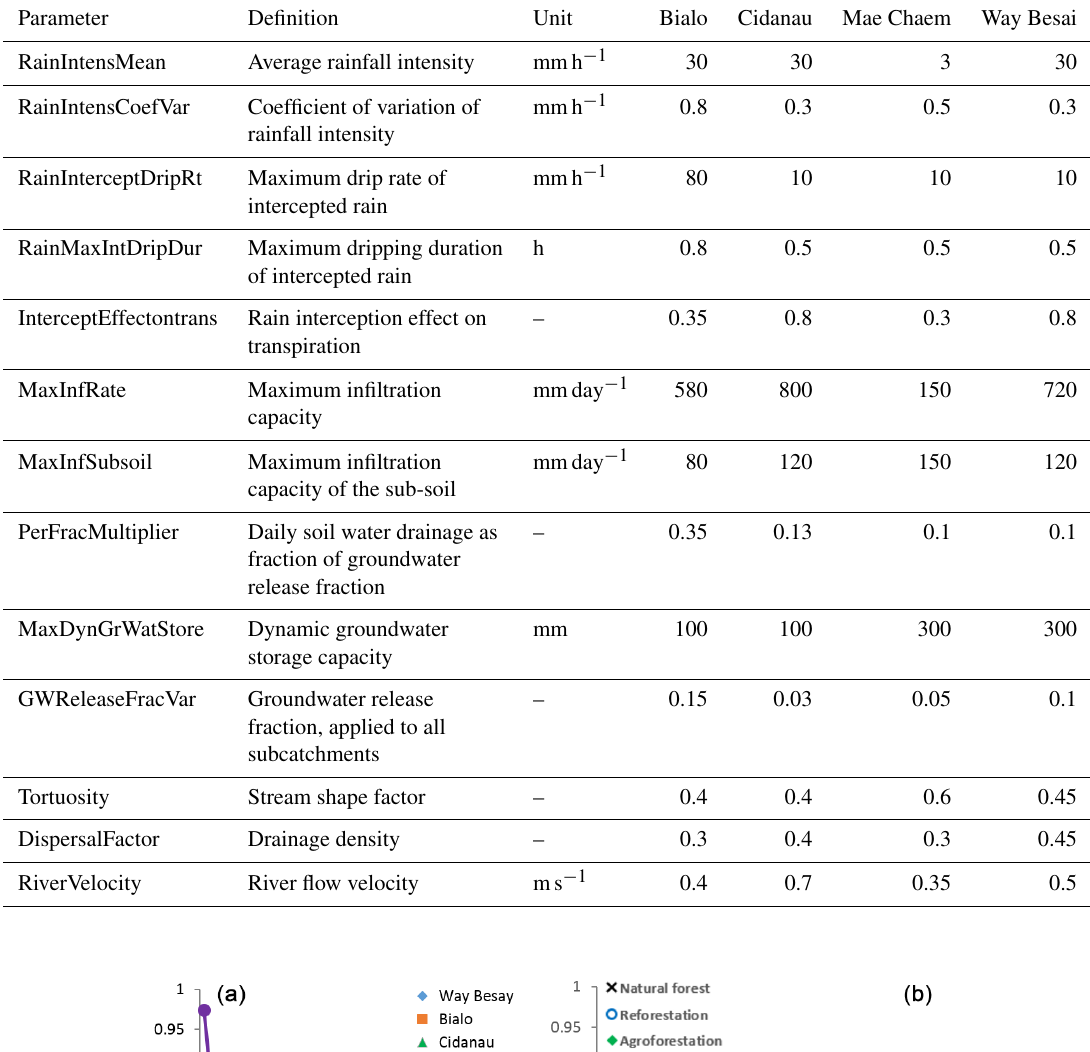
Table 2. Parameters of the GenRiver model used for the four site-specific simulations (van Noordwijk et al., 2011 for definitions of terms; sequence of parameters follows the pathway of water).